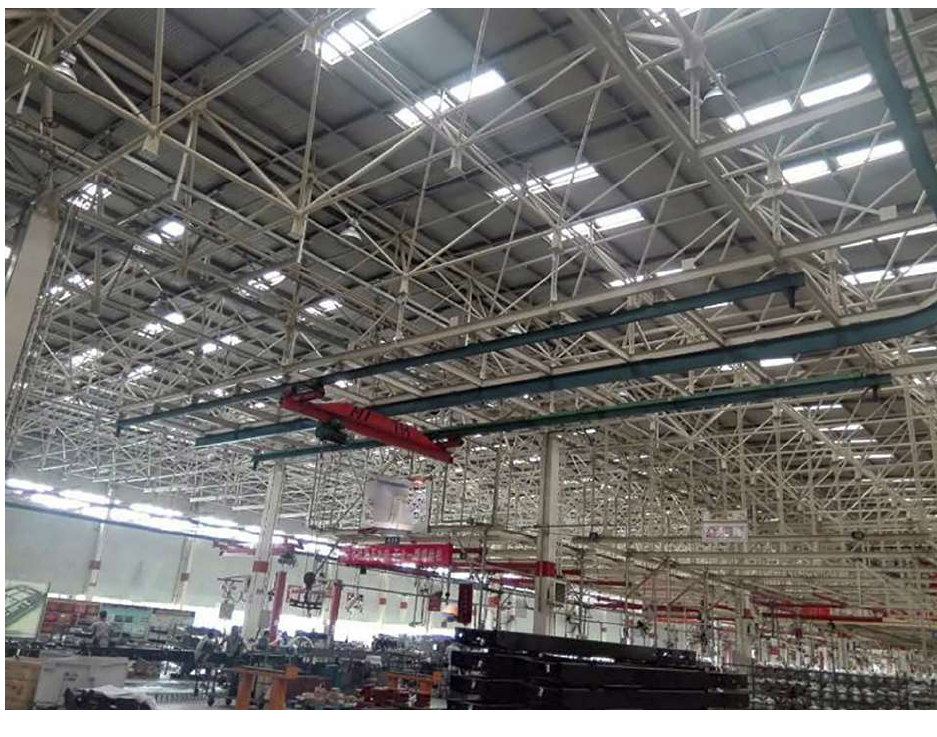
Figure 1. The applications of grid structures with suspended cranes.